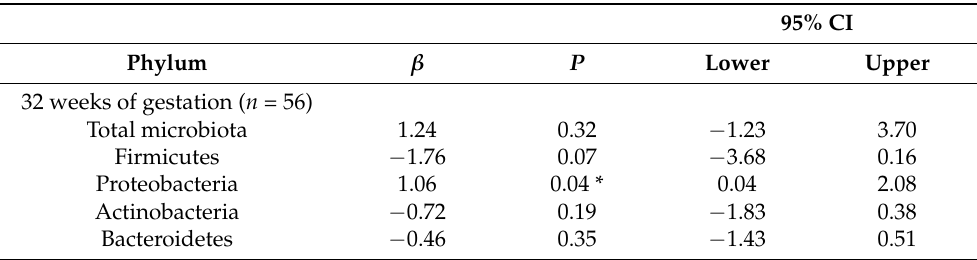
Table 5. Associations between the SDIs of total microbiota and four phyla in maternal feces at 32 weeks of gestation and non-specific IgE levels in maternal sera 1